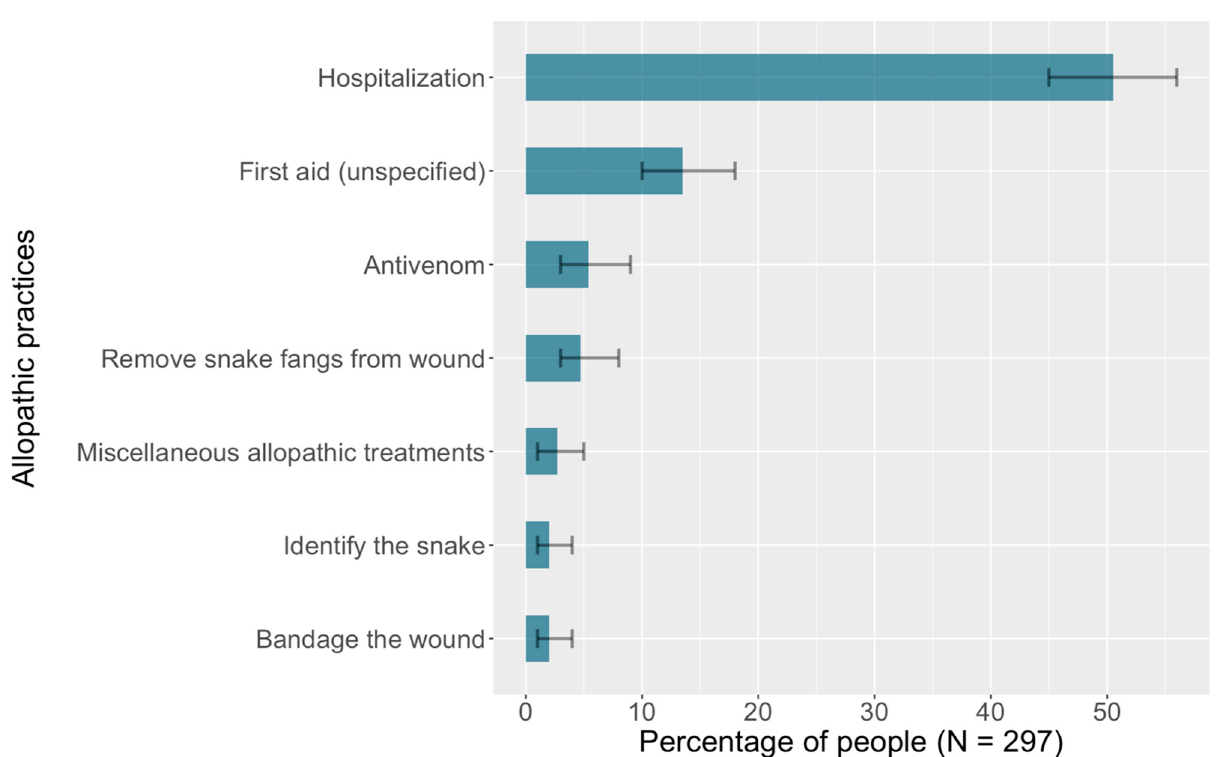
Figure 2. Allopathic community practices to treat snakebite.